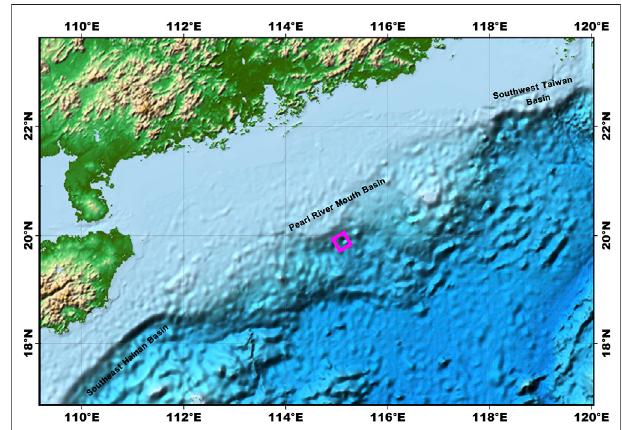
FIGURE 3 | Location map of VCS acquisition in the study area. The pink square frame indicates the area of VCS operation.